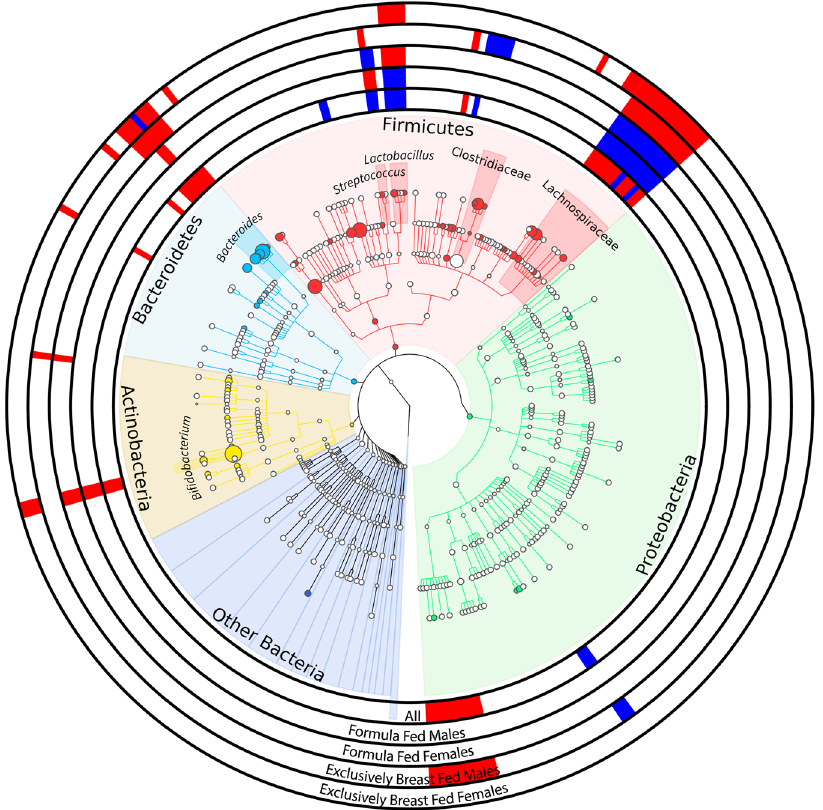
Figure 2. Cladogram showing bacterial OTUs with differential relative abundances based on arsenic levels. Color-shaded areas of the cladogram delineate the most abundant phyla in the infant gut microbiota, with the size of corresponding nodes proportional to the abundance level of the clades. Several OTUs were significantly associated with arsenic levels; bars in the outer rings identified individual OTUs that were positively (blue bars) and negatively (red bars) correlated with urine arsenic concentrations. Rings correspond to all infants in the study (N = 204), male formula-fed infants only (N = 33), female formula-fed infants only (N = 23), male exclusively breastfed infants only (N = 85) and female exclusively breastfed infants only (N =